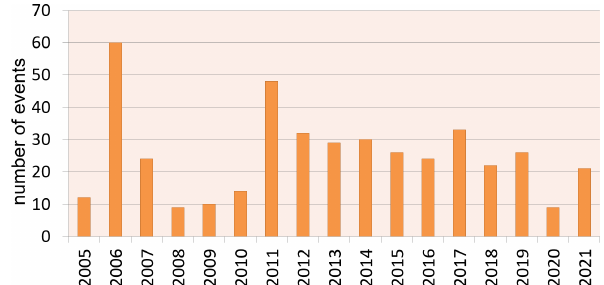
Figure 2. Distribution of freak wave accidents by years.